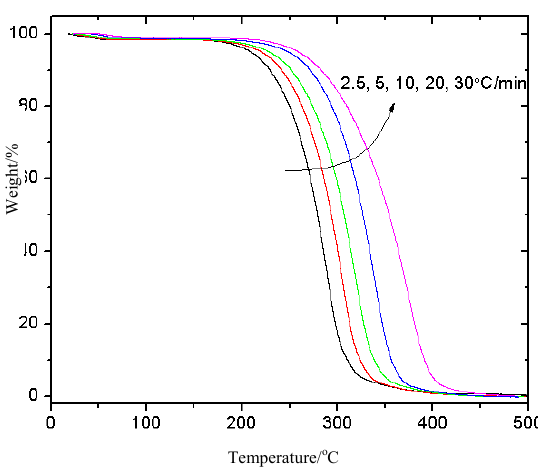
Figure 4. TGA curves of N-(benzoyl) stearic acid